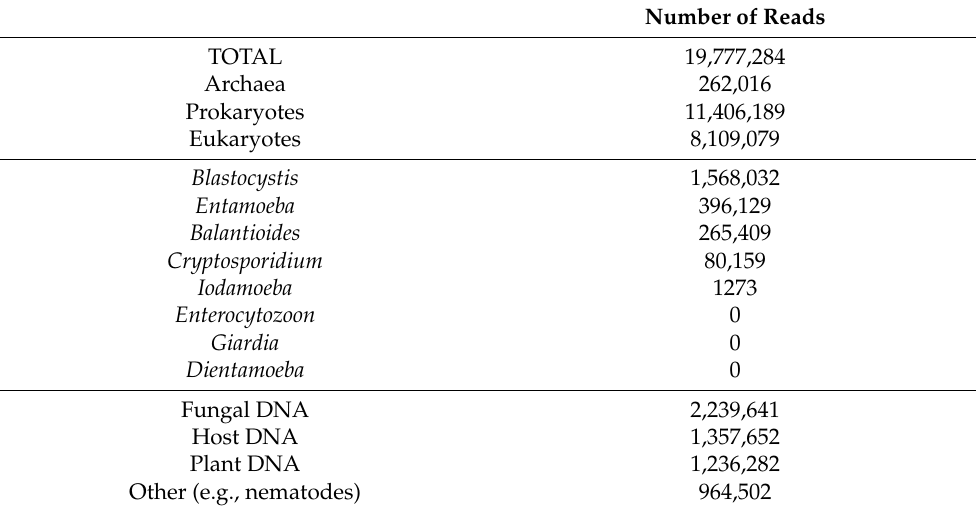
Table 4. Total number of DNA sequence reads generated by the metabarcoding assay according to taxonomic group across all primers